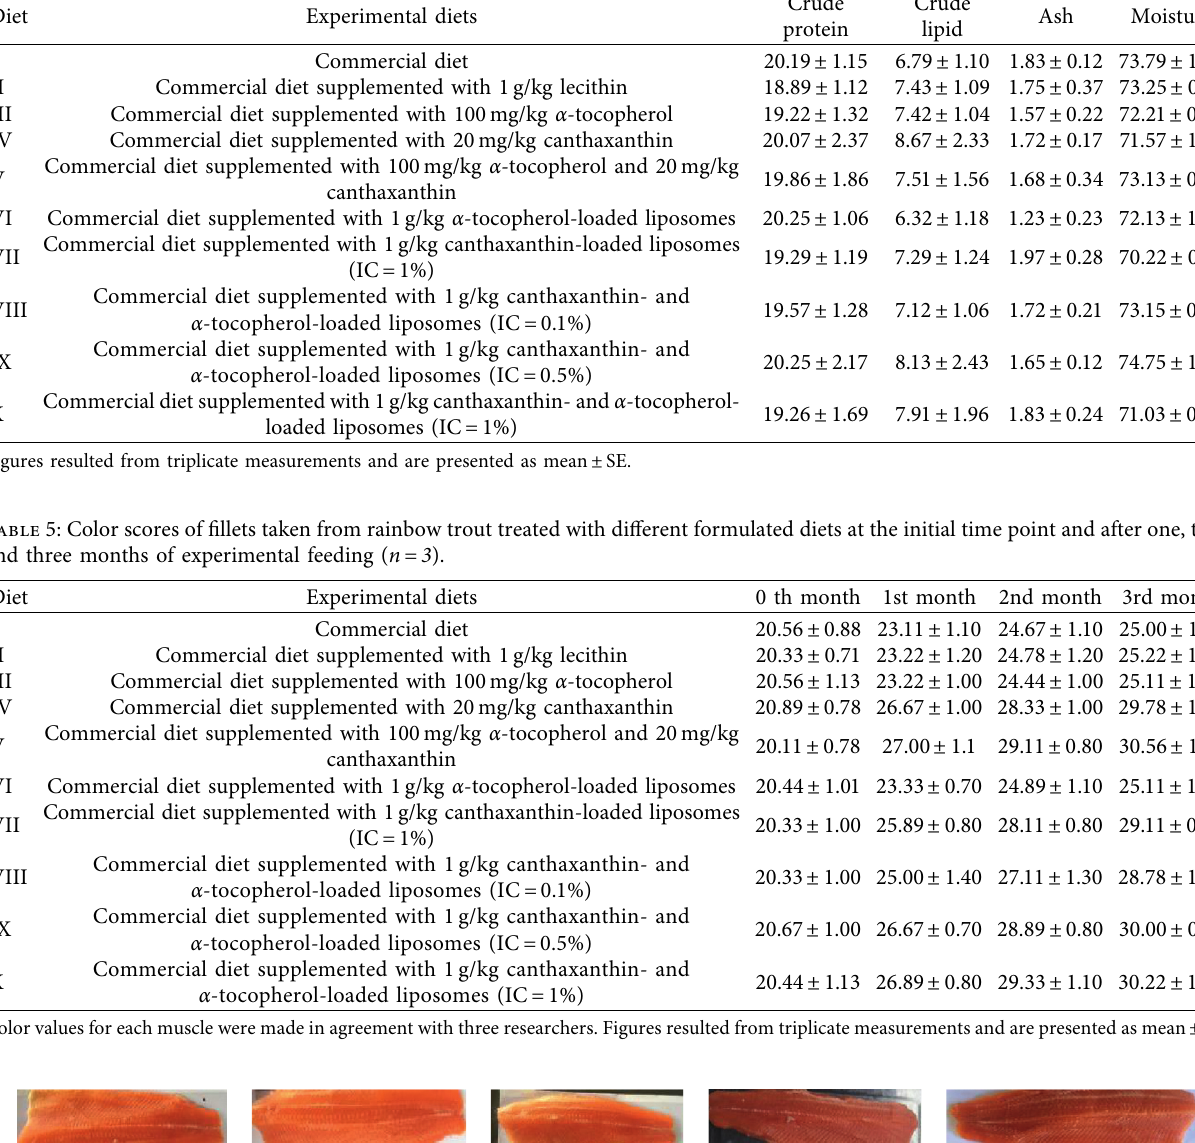
Table 4: Proximate composition of the muscle of rainbow trout after 3 months of feeding with experimental diets ( n � 3 , unit: % wet weight). Diet Experimental diets